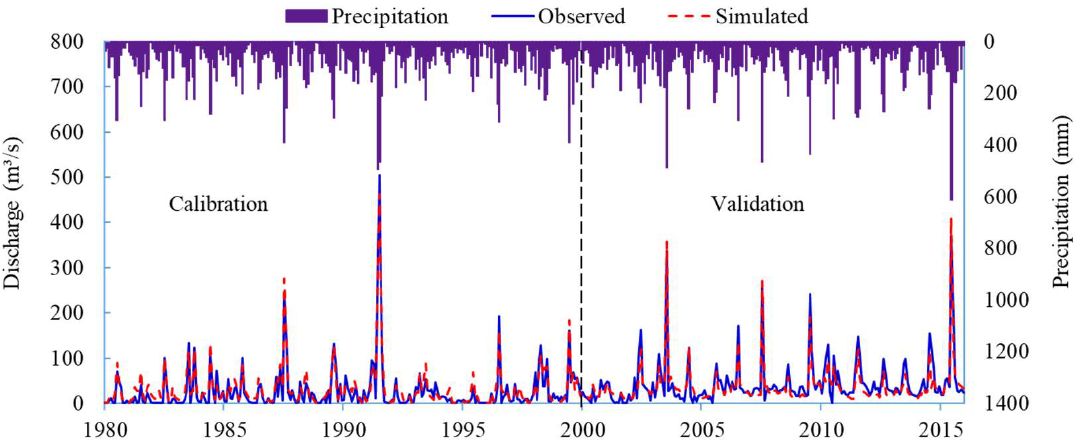
Figure 5. The daily flow duration curves of the catchment.